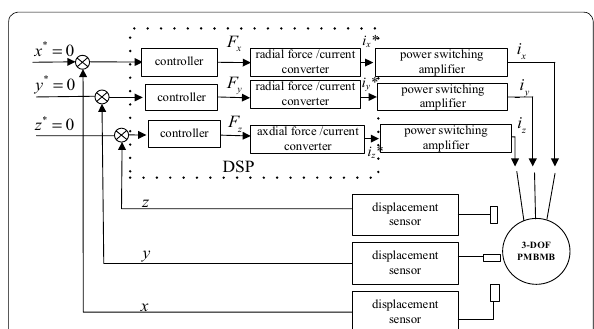
Figure 10 Block diagram of the control system for